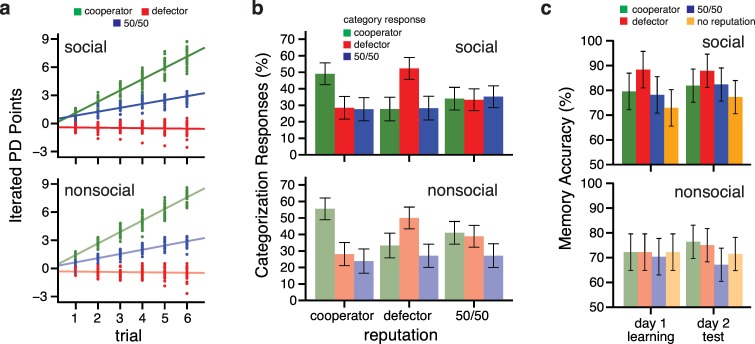
Establishing reputations and memory of associations for the social (saturated) and nonsocial framing groups (lighter).(a) Average points won during the six trials within a mini-block during the iterated EG task separated by player type (cooperator–green, defector–red, and 50/50 –blue). Points represent individual subject point totals and solid lines depict the player type regression lines from the linear mixed effects model. (b) Average percentage of category responses during the categorization task on day 2 separated by actual player type and further by categorized player type. Error bars represent 95% confidence intervals of the mean. c) Average associative memory performance at the end of day 1 learning (left bars) and day 2 memory test (right bars) separated by reputation condition type (cooperator–green, defector–red, 50/50 –blue, no reputation–yellow). Error bars represent 95% confidence intervals of the mean.